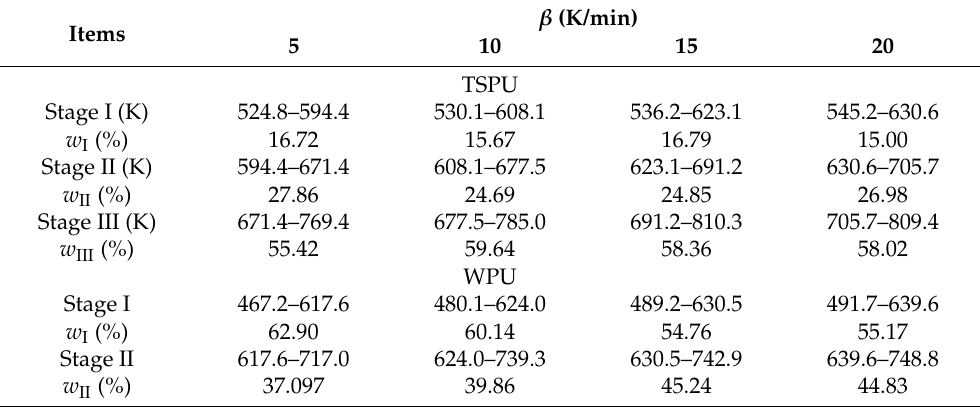
Table 1. Temperature ranges for multi-stage pyrolysis of two polyurethane